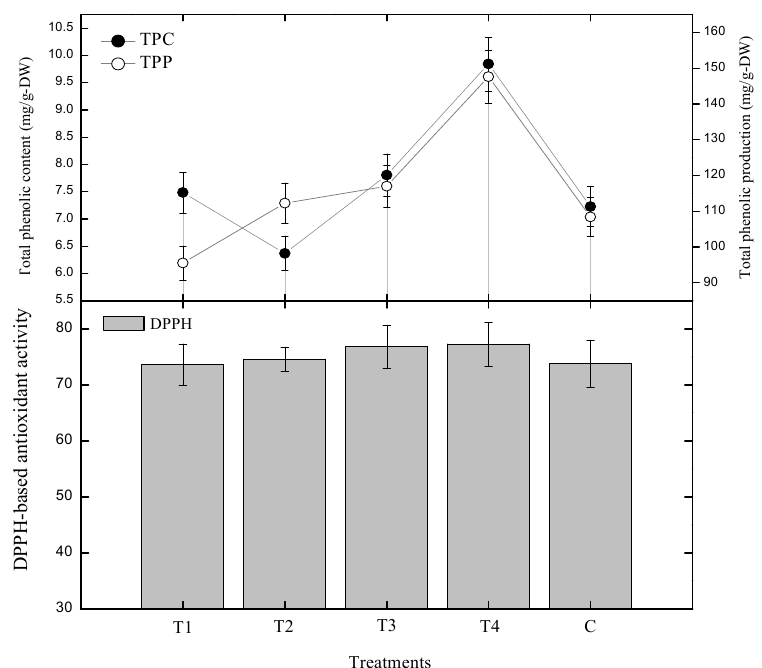
Figure 5. Correlation between DPPH-based antioxidant activity and flavonoids in S. rebaudiana adventitious root cultures in vitro. The triplicate data in the mean along with standard errors (SE) are significantly different at p < 0.05.